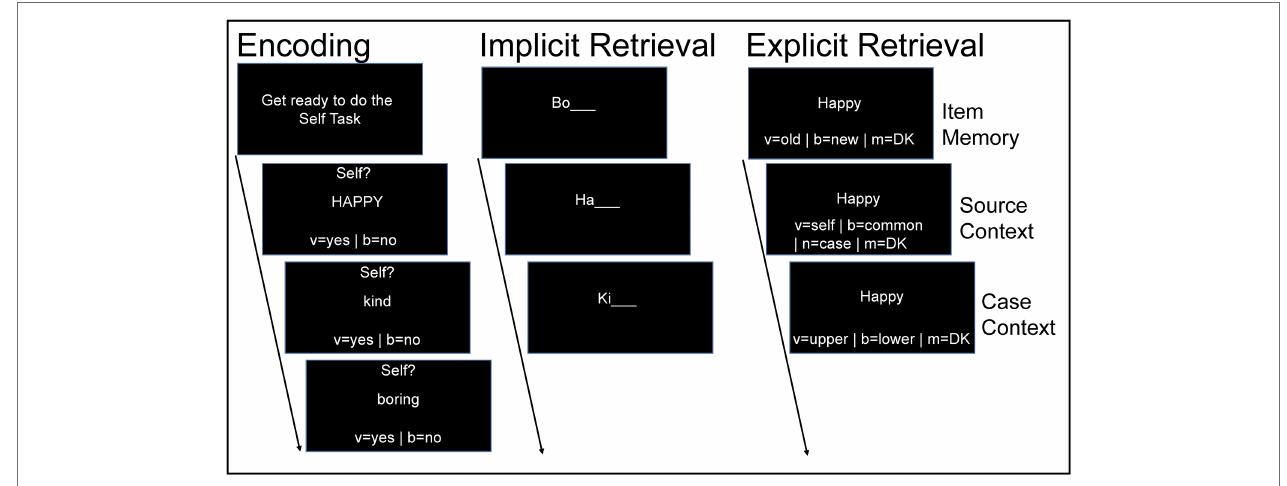
FIGURE 1 | Trial depiction of the encoding, implicit retrieval, and explicit retrieval phases of the experiment. “DK” means “do not